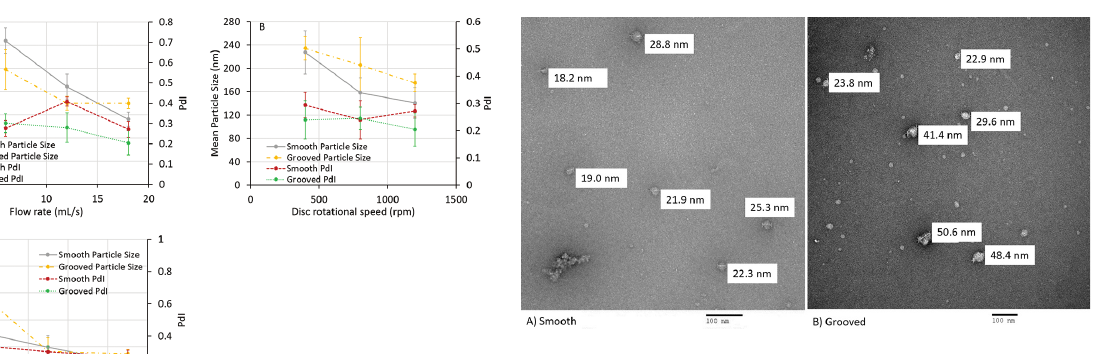
Figure 14: TEM image at 18 mL/s, 9:1 ratio and 1200 rpm for